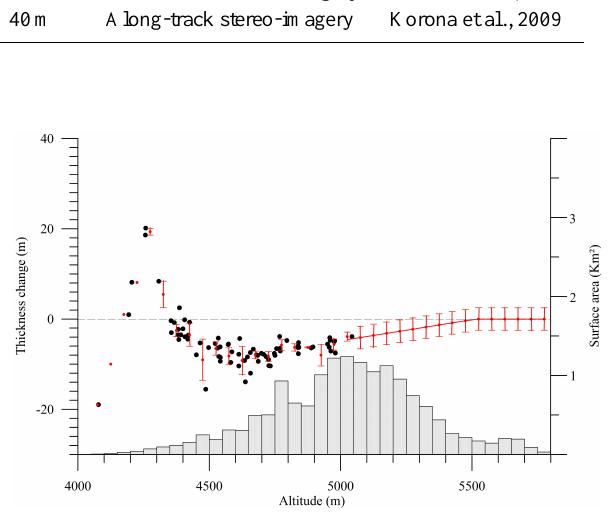
Fig. 3. Thickness changes as a function of altitude (measurements (black dots)). Below 5100m a.s.l., mean thickness changes have been calculated within each altitude range from measurements (red dots). Above 5100m, the thinning trend observed between 4700 and 5100m has been extrapolated using a linear regression with altitude to zero mass balance (red